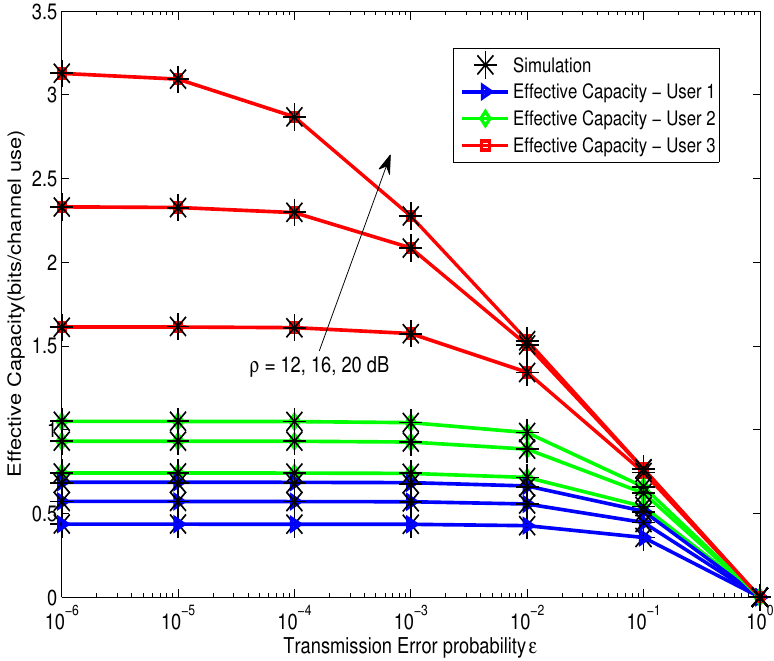
Figure 4. Effective capacity vs. the transmission error probability ε , with n = 300, and θ 1 = θ 2 = θ 3 =